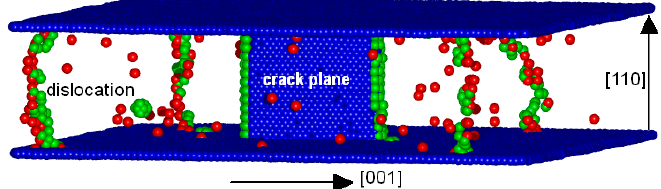
Figure 8. Temperature 600 K, uniaxial tension α = 0.0: 3D visualization of the four <111>{112} dislocations (red and green) and of the isolated (red) interstitials at time step 5500 ( ∆ t = 4500 h , K A (t) = 0.518 MPa·m 1/2 ).